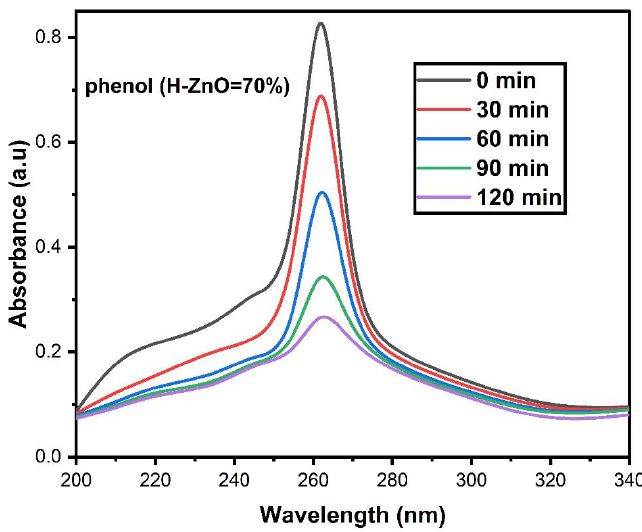
Figure 9. ( a ) Photocatalytic activity of H-ZnO; ( b ) of ZnO; ( c ) degradation efficiency and ( d ) mech- anism of ZnO nanoparticles.